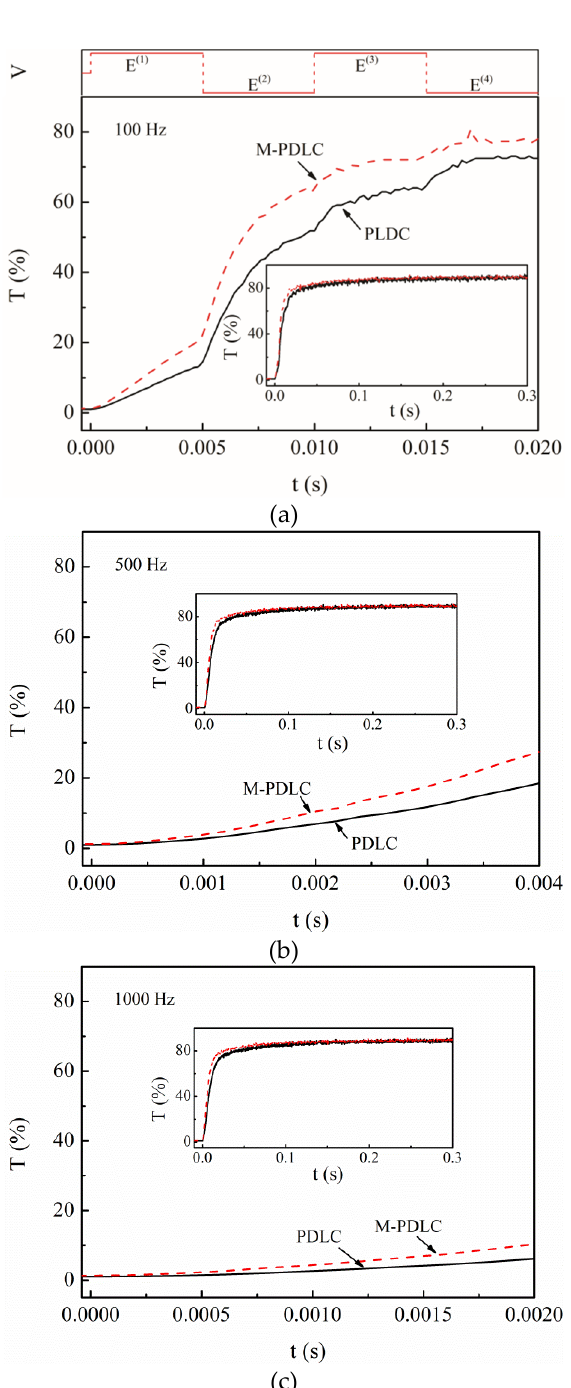
Figure A3. The T-t curves of the un-doped and doped PDLCs under AC applied voltage . ( a ) 100 Hz, ( b ) 500 Hz, ( c ) 1000 Hz.